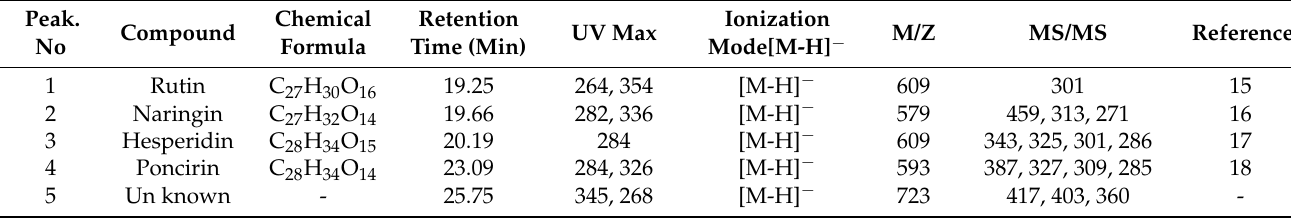
Table 2. Regression data, LODs, LOQs for four external standards and amount of flavonoids from Citrus unshiu peel.